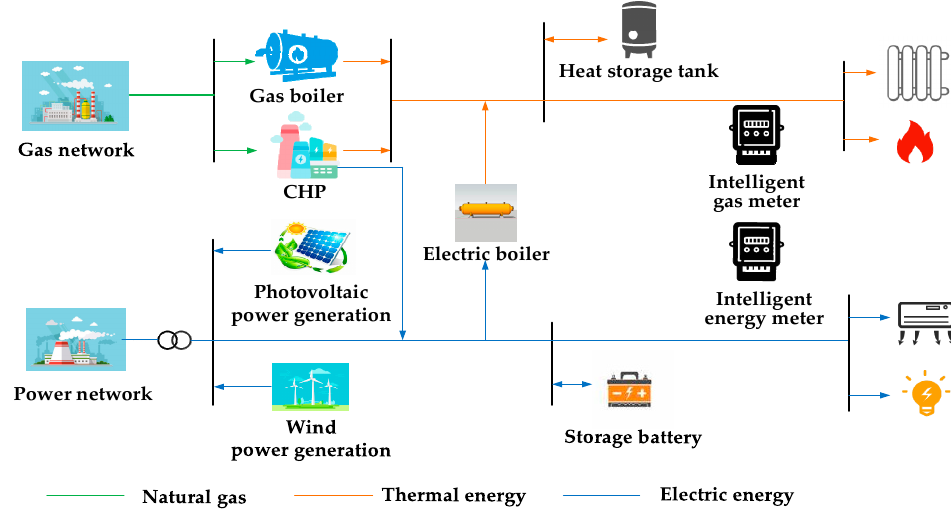
Figure 1. Basic structure of EH.